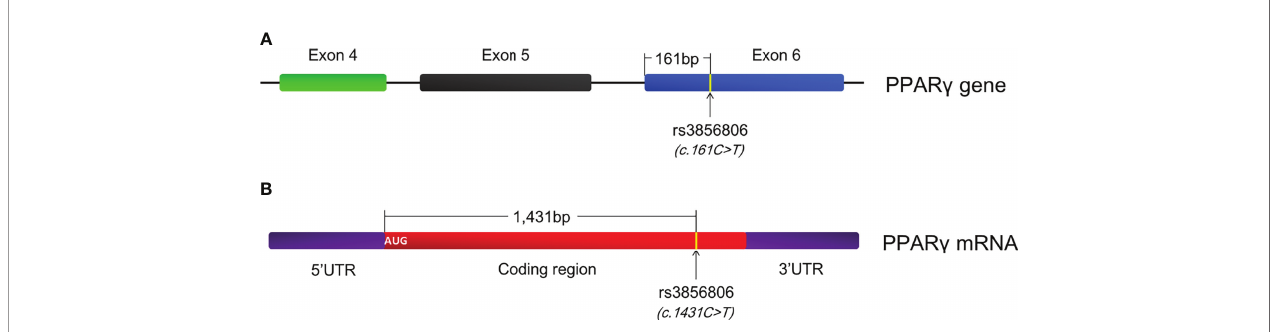
FIGURE 3 | Annotation of the rs3856806 polymorphism in PPAR g gene. (A) c.161C>T is de fi ned according to the position of this variant in exon 6 of PPAR g gene; (B) c.1431C>T is de fi ned according to the position of this variant in PPAR g 2 mRNA; PPAR g , peroxisome proliferator-activated receptor